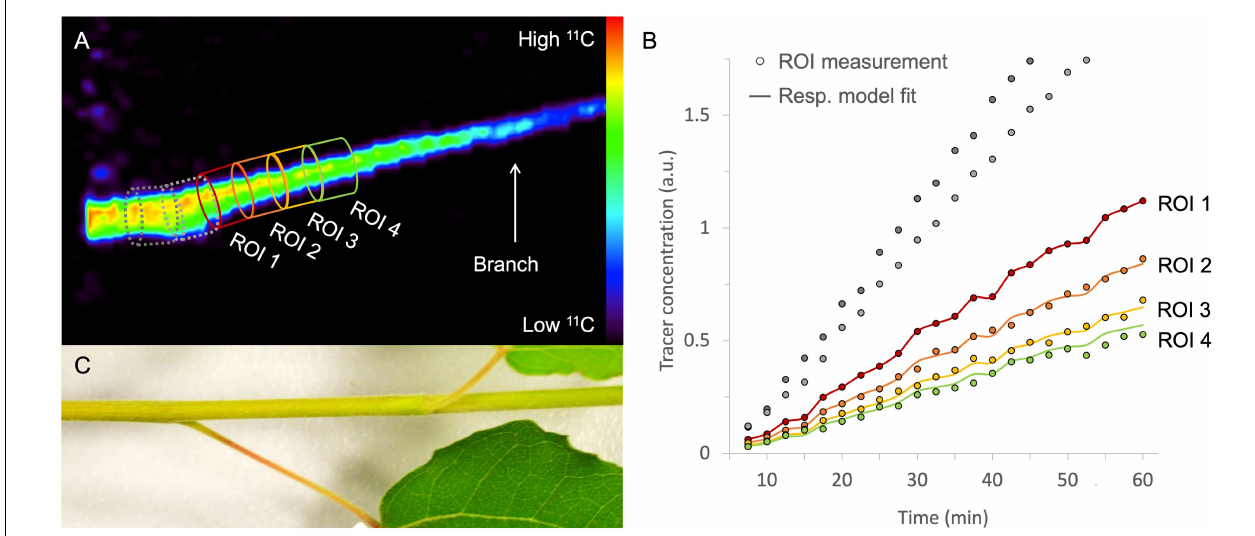
FIGURE 7 | Example of a static volume rendered PET image showing xylem-transported 11 CO 2 in a branch segment of Populus tremula (A) . By extracting the tracer concentrations within, e.g., four consecutive ROIs of the corresponding dynamic PET images (e.g., 2.5 min time frames) time-activity curves (TACs) are obtained [circles in panel (B) ]. Time is expressed in minutes after pulse-labeling aqueous 11 CO 2 to the cut end of the branch. By means of mathematical frameworks a model, representing the molecular system under study, can be fitted continuous lines) to the measured TACs. The importance of pursuing good region of interest (ROI) drawing practices is demonstrated by knowing which corresponding plant part is inside the field of view (C) . It would be straightforward to draw ROI 1 on the branch segment having the highest tracer concentration [dotted ROIs in panel (A) ]. On the branch segment enclosed in these ROIs however, a petiole originates, which cannot be resolved from the branch itself due to the limited spatial resolution of the PET system. Therefore, the 11 C-tracer detected in the branch and the petiole is added in these ROIs, resulting in an incorrect higher signal and eventually incorrect TACs [gray ROI measurements in panel (B) ]. These ROI data sets were therefore excluded from parameter calibration and thus do not have a continuous model fit. Note that PET image (A) shows the side view whereas the branch (C) is shown from